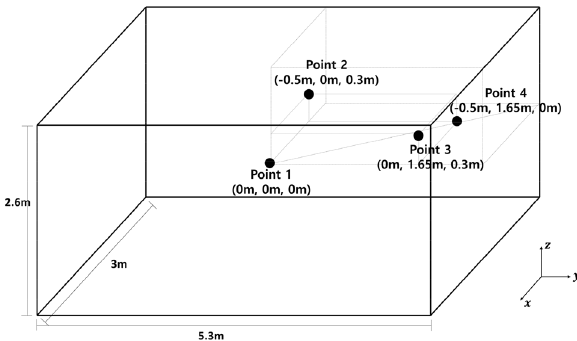
Figure 3. Candidates of noise source location in enclosed space.